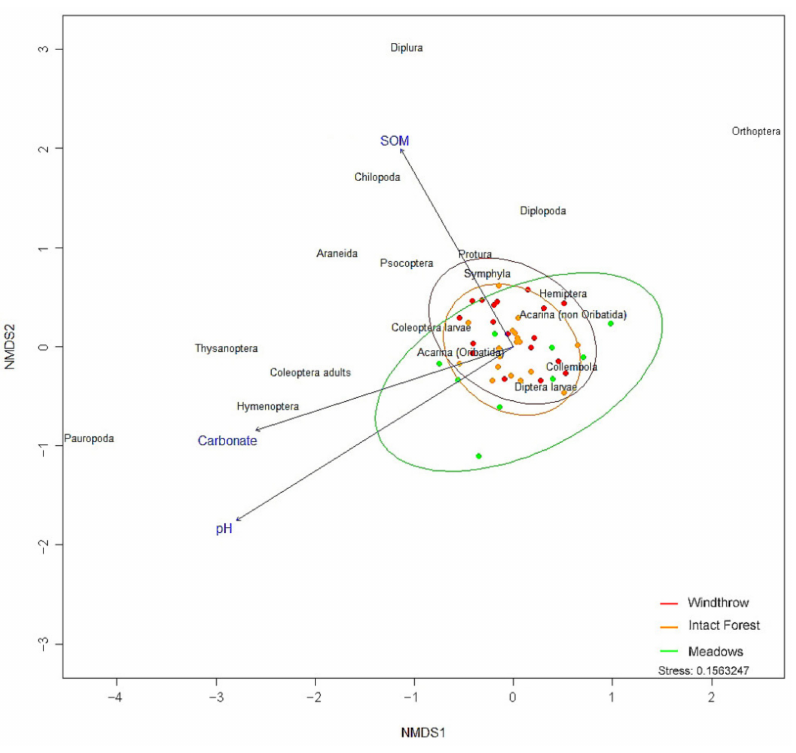
Figure 3. Bray–Curtis-based NMDS plot of arthropod community composition. Points represent samples.